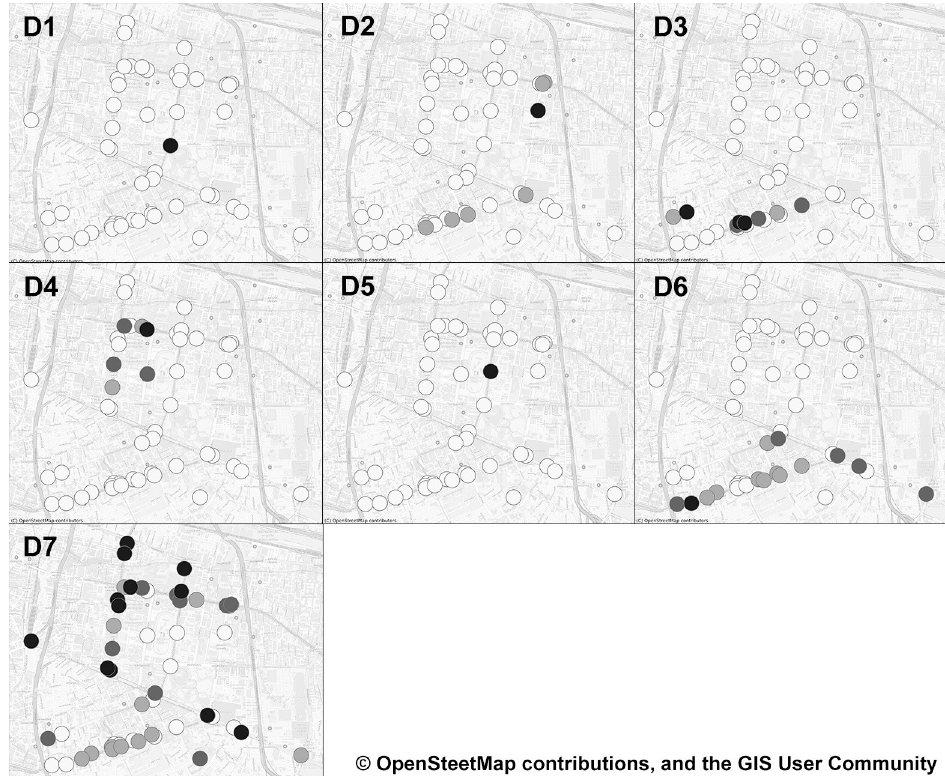
Fig 9. Groups of destination stations identified by a non-negative Tucker decomposition approach. These figures contain a base map from OpenStreetMap and OpenStreetMap Foundation, which is made available under the Open Database